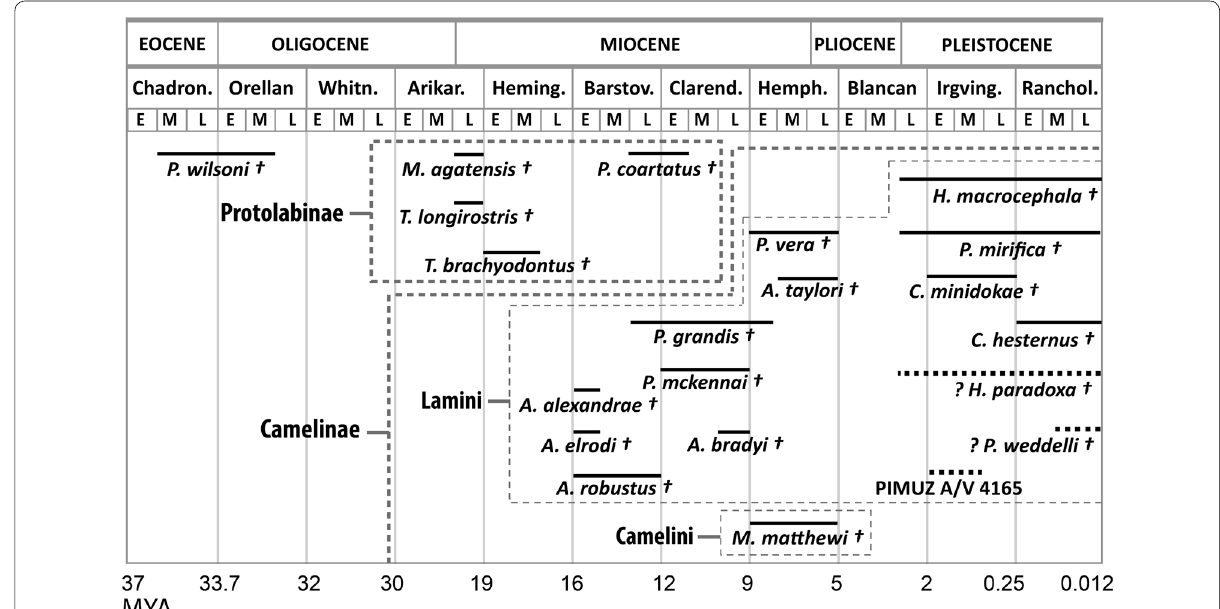
Fig. 1 Time range of extinct species included in this study. Not to scale, species time range approximate. Species positioning in the Protolabinae follows Honey (1998) and Honey (2007). Species positioning in the Camelinae, Lamini, and Camelini follow our results. Species range for North American species following Baskin and Thomas (2016); Bravo‑Cuevas and Jiménez‑Hidalgo (2015); Harrison (1979); Honey and al. (1998); Honey and Taylor (1978); Pagnac (2005); Peterson (1911); Prothero (2005); Webb and Meachen (2004). Absolute ages for North American land mammal age following Woodburne (2004). Species range for South American species are uncertain and discussed by Scherer (2013). Absolute ages for South American land mammal age following Verzi et al. (2004); Soibelzon and al. (2008); Cione and Tonni (2001); Cione and Tonni (2005); Cione et al. (2015). Abbreviations: Chadron. Chadronian; Whitn. Whitneyan; Arikar. Arikareean; Heming. Hemingfordian; Barstov. Barstovian; = = = = = Clarend. Clarendonian; Hemph. Hemphillian; Irving. Irvingtonian; Ranchol. Rancholabrean; E early; M middle; L = = = = = = =